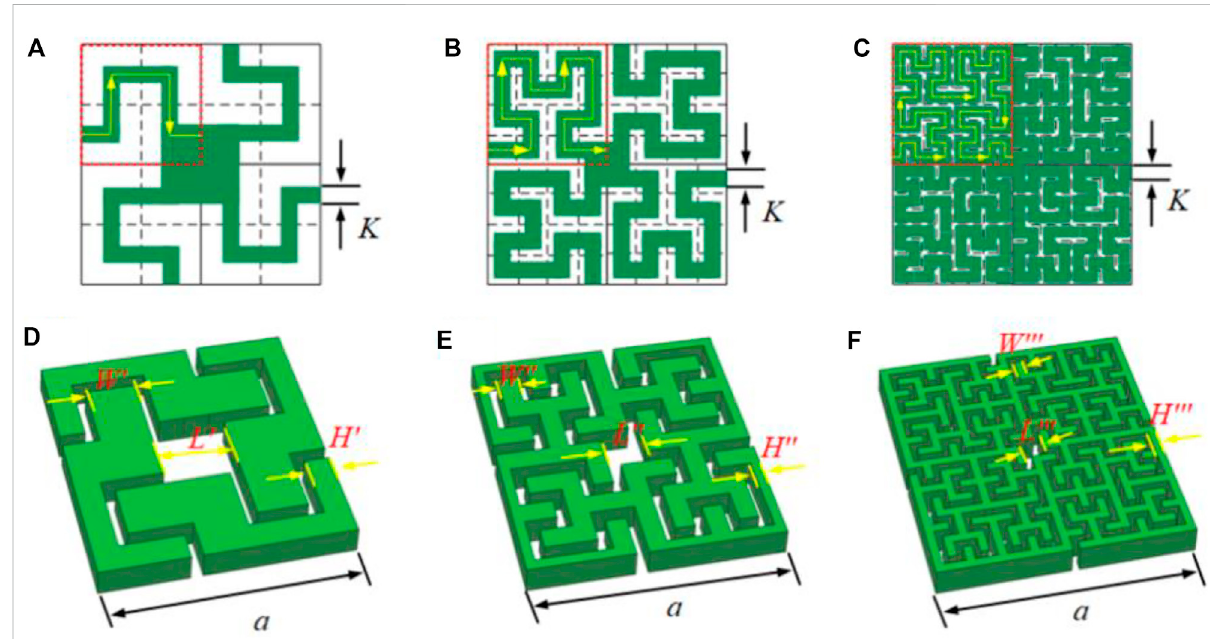
FIGURE 8 Schematic cross-sectional illustrations of three types of unit cells of HFAM: (A – C) The Hilbert curve channel of the fi rst to third order HFAM with fl uid. (D – F) The oblique drawing of unit cells of the fi rst to third order HFAM. The material of HFAM applied is epoxy resin. The geometric and property parametersofHFAMarelisted: a =105 mm, K =5 mm; H ’ =10.625 mm, H "=4.0625mm, H "=0.7812 mm: W ’ =21.25 mm, W "=8.125 mm, W " ’ =1.5625 mm: p = 1,050 kg/m, c = 2,500 m/s and p c o = 1.25 kg/m, o = 343 m/s. Reprinted from [29] with